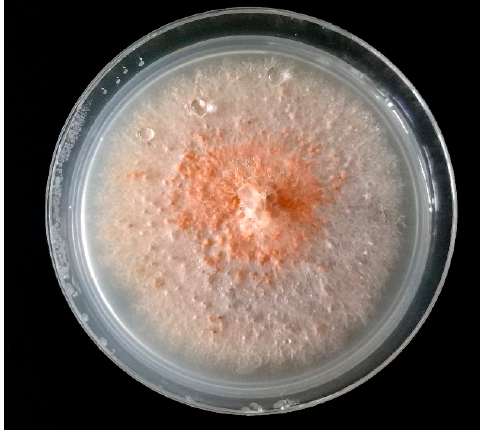
Figure 4. Colletotrichum acutatum isolated on PDA medium from ecological strawberry plantation after 10 days of incubation in 22 °C.